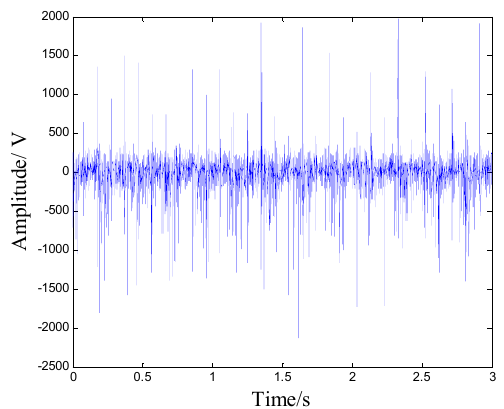
Figure 31. The time domain plot of broken gear.